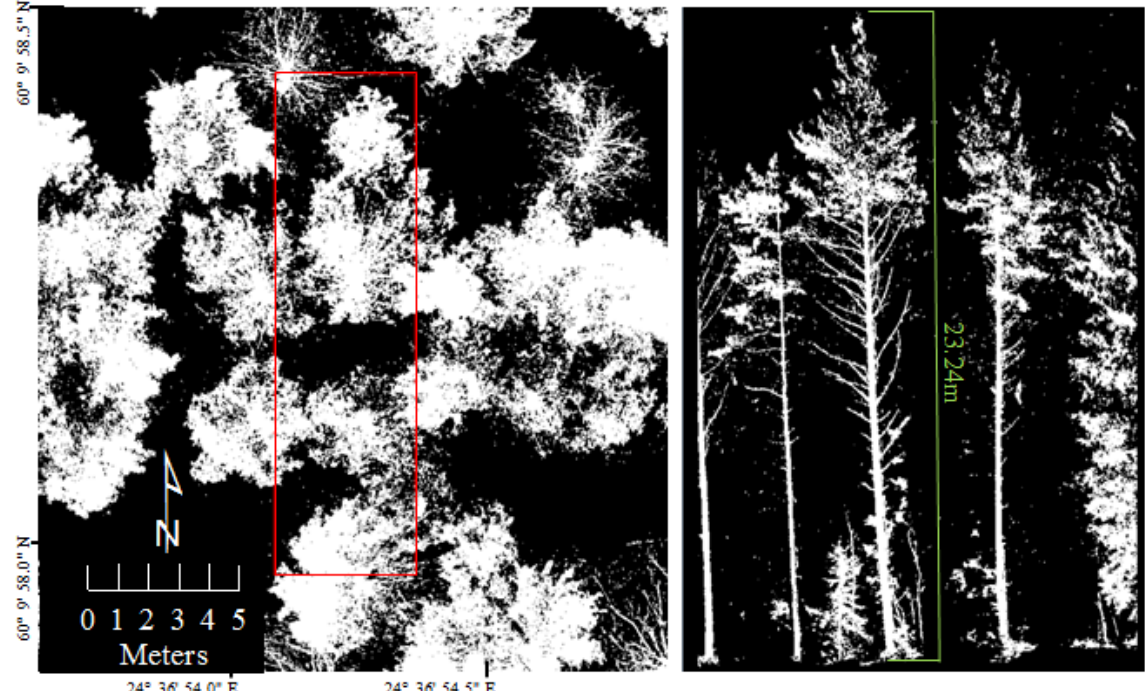
White: 3D tree vectors; Crop area for side view; Height reading for one